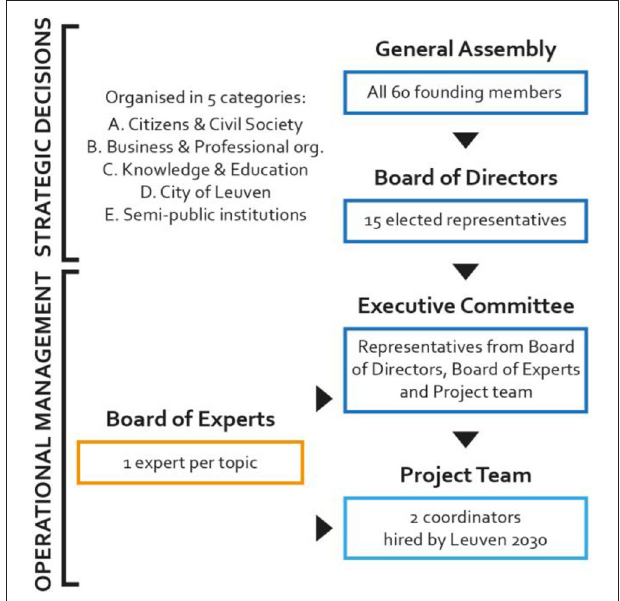
FIGURE 5 | Original internal governance structure in LKN